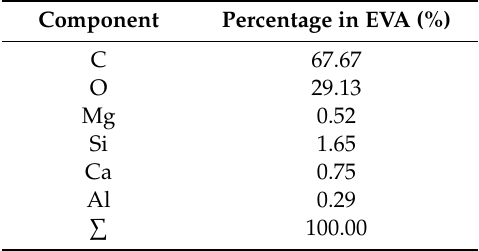
Table 3. Chemical composition of the redispersible polymer powder used in this